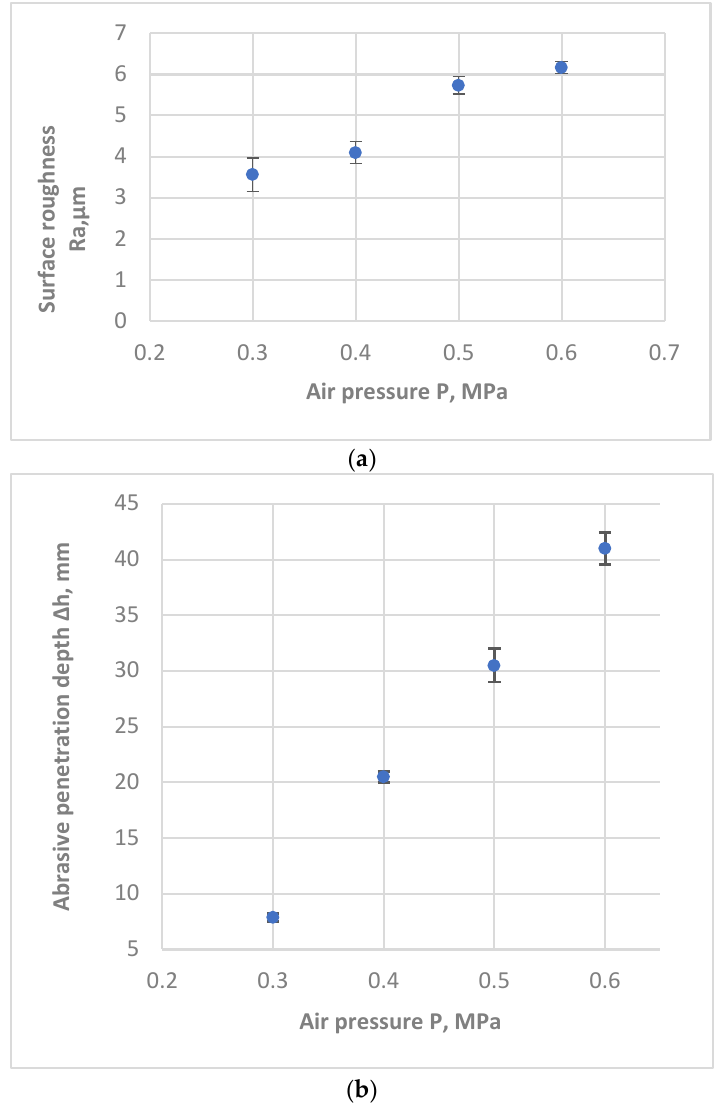
Figure 5. Dependence of surface roughness Ra ( a ) and depth of penetration of abrasive ∆h ( b ) on air pressure P (nozzle attack angle—80°; processing time t—3 min, 30 s).